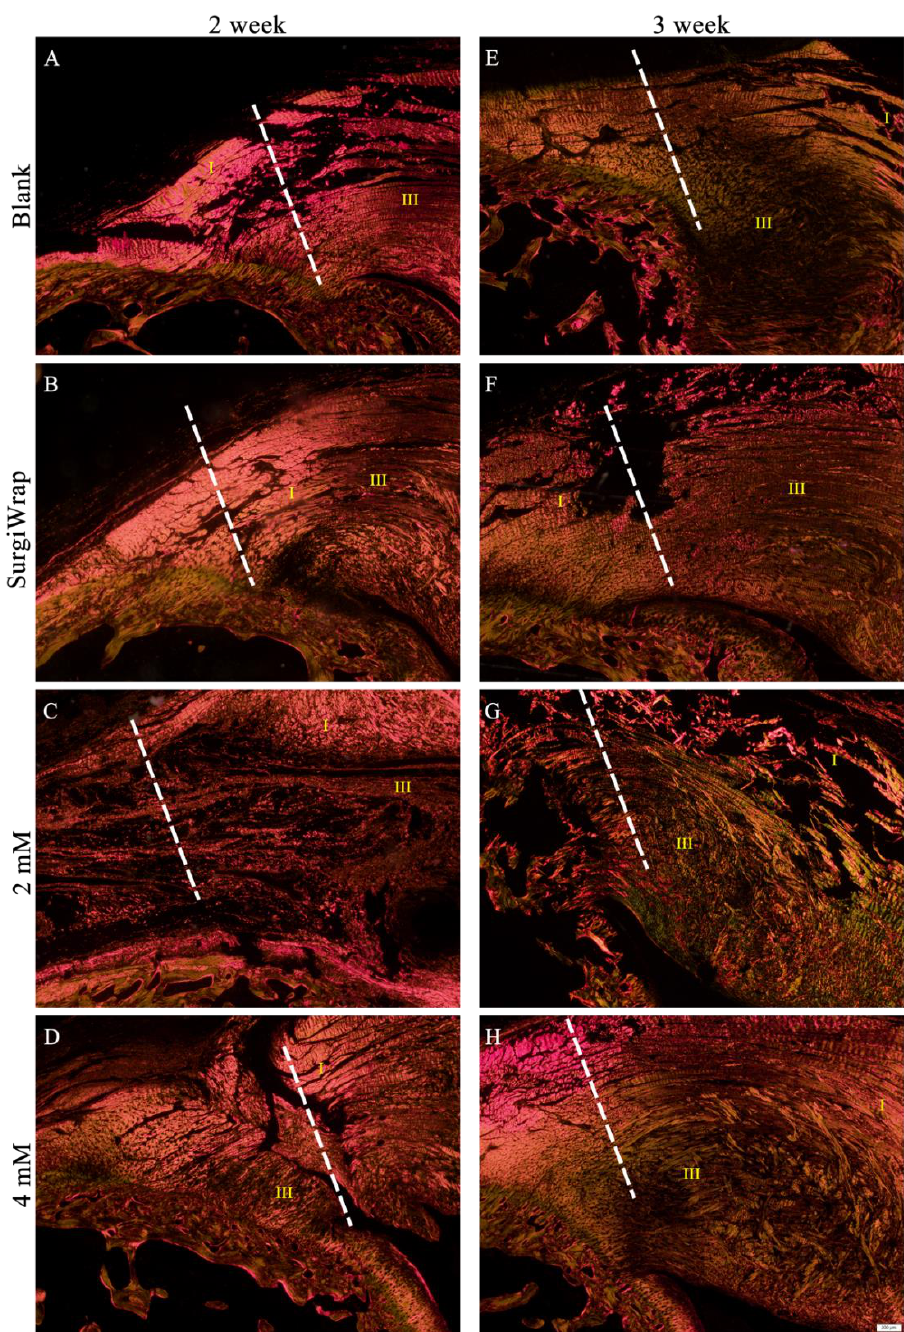
Figure 8. RC tears stained with picrosirius red to show type I collagen and type III collagen (bright red and green, respectively) 2 weeks ( A : without membrane, B : covered with SurgiWarp, C : covered with 2 mM farnesol-impregnated membrane and D : covered with 4 mM farnesol-impregnated membrane) and 3 weeks ( E : without membrane, F : covered with SurgiWarp, G : covered with 2 mM farnesol-impregnated membrane and H : covered with 4 mM farnesol-impregnated membrane) postoperation, after treatment with hydrogel membranes. RC: rotator cuff; I: type I collagen; III: type III collagen. The dashed lines indicate RC tear sites. Scale bar: 200 µ